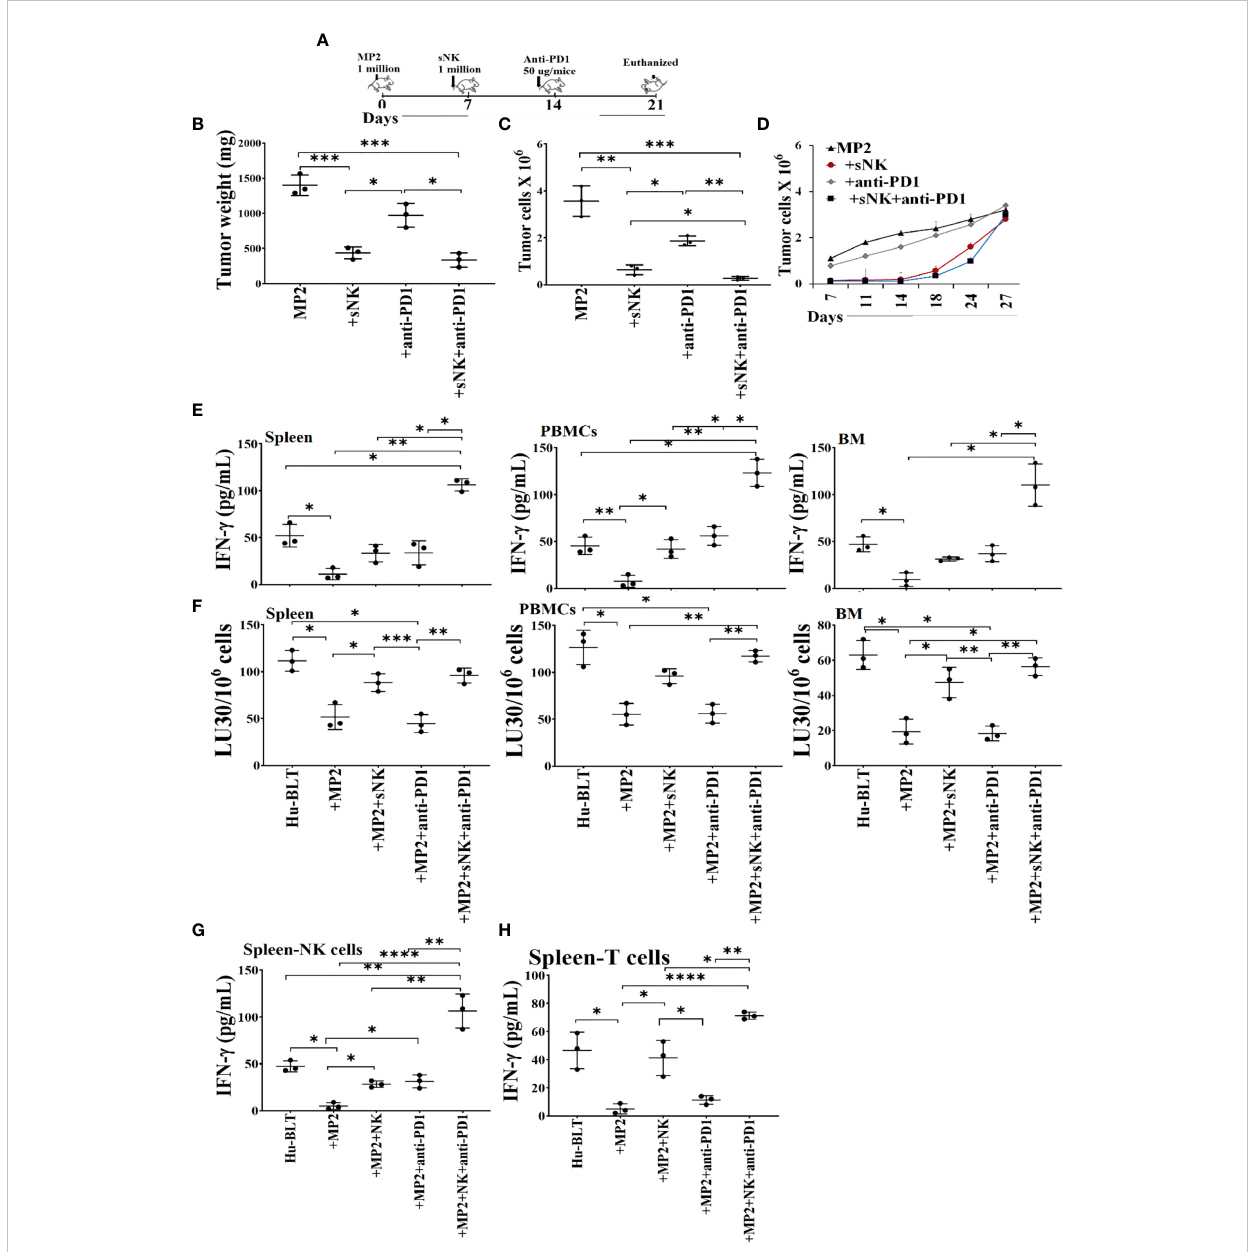
FIGURE 7 Combination of sNK cells and anti-PD1 antibody halted the growth of MP2 tumors, and increased IFN- g secretion and cytotoxic function by PBMCs, splenocytes and bone marrow derived immune cells from hu-BLT mice. Hu-BLT mice were orthotopically injected with 1 x 10 6 human MP2 tumors in the pancreas. One week after the tumor implantation, mice received supercharged NK (sNK) cells via tail-vein injection, and one week after sNK cell injection, mice received anti-PD1 (50 µg/mice) antibody via tail vein. The disease progression was monitored for another week (A) . Hu-BLT mice were implanted with MP2 tumors and were injected with sNK cells and anti-PD1 antibody as depicted in Figure 7A. At the end of the experiment, hu-BLT mice were sacri fi ced and the tumors were harvested and weighed (n=3) (B) . Hu-BLT mice were implanted with MP2 tumors and were injected with sNK cells and anti-PD1 antibody as depicted in Figure 7A. At the end of the experiment, hu-BLT mice were sacri fi ced and the tumors were harvested and single-cells were isolated as described in Materials and Methods section. Tumor cells were counted microscopically (n=3) (C) . Hu-BLT derived tumors were cultured at 0.15 x 10 6 /ml at the initiation of the tumor cultures, and the cell growth were determined on the days shown in the Figure. Statistical analysis is shown for sNK or sNK+anti-PD1 antibody group vs. untreated group (n=3) (D) . Hu-BLT mice were implanted with MP2 tumors and, were injected with sNK cells and anti-PD1 antibody as depicted in Figure 7A. At the end of the experiment, hu-BLT mice were sacri fi ced and the spleens, peripheral blood, and bone marrow were harvested, and single cell suspensions were prepared and cultured in the presence of IL-2 (1000 U/ml) for 7 days. On day 7, the supernatants were harvested and the secretion of IFN- g was determined using single ELISA (n=3) (E) . Splenocytes, and peripheral blood and bone marrow derived immune cells were cultured in the presence of IL-2 (1000 U/ml) for 7 days. On day 7, cells were used as effectors against OSCSCs using standard 4-hour 51 Cr release assay. The Lytic units (LU) 30/10 6 cells were determined using the inverse number of cells required to lyse 30% of OSCSCs x 100 (n=3) (F) . NK (G) and CD3+ T (H) cells were puri fi ed from the spleen and cultured in the presence of IL-2 (1000 U/ml for NK cultures; and100 U/ ml for T cell cultures) for 7 days. On day 7, the supernatants were harvested and the secretion of IFN- g was determined using single ELISA (n=3) (G, H) . ****(p value<0.0001), ***( p value 0.0001-0.001), **( p value 0.001-0.01), *( p value